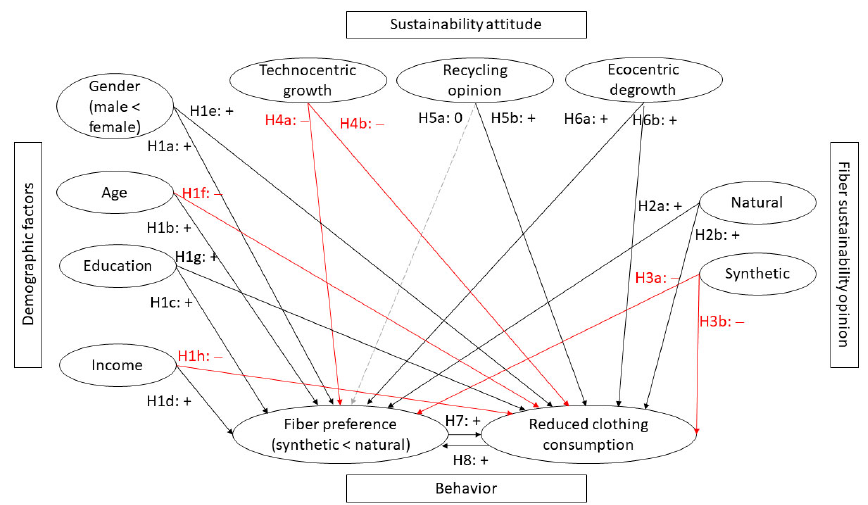
Figure 1. Hypothesis model. Black full lines indicate positive correlations, red lines negative correlations, and stapled line indicates the null hypothesis (no significant correlation).